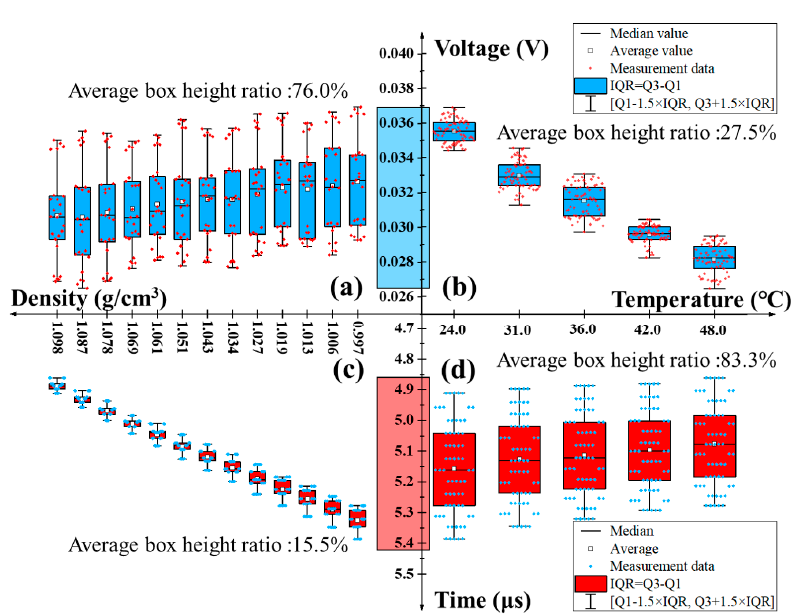
Figure 4. Boxplot of the measured V and t in response to various groups of temperatures and densities. Dependence of V upon ( a ) ρ and ( b ) T and dependence of t upon ( c ) ρ and ( d ) T .